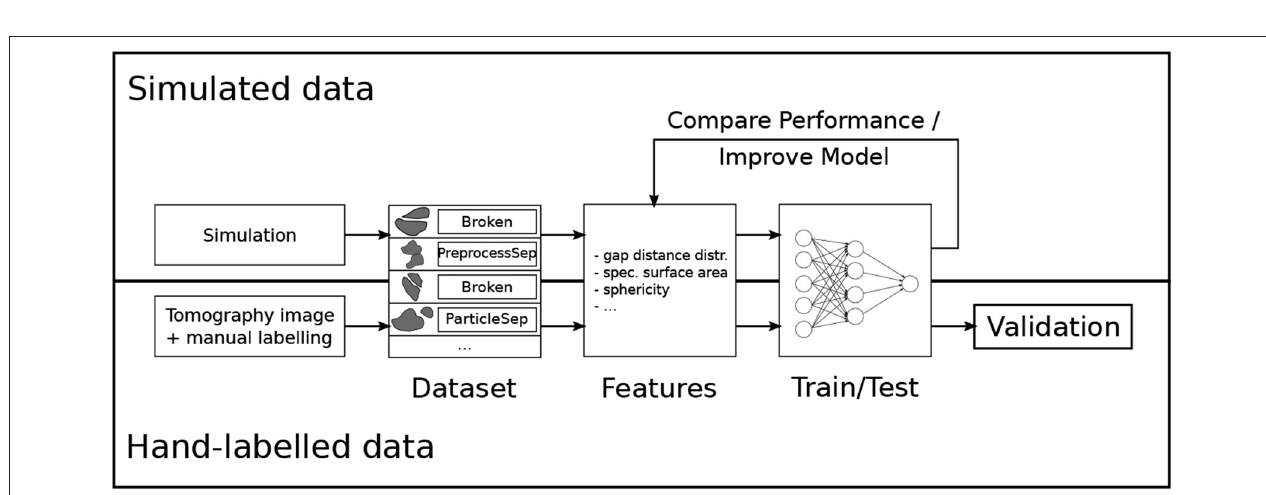
FIGURE 3 | Overview of the model development for the crack detection in lithium-ion batteries. Reprinted from Petrich et al. (2017), Figure 1, with permission from